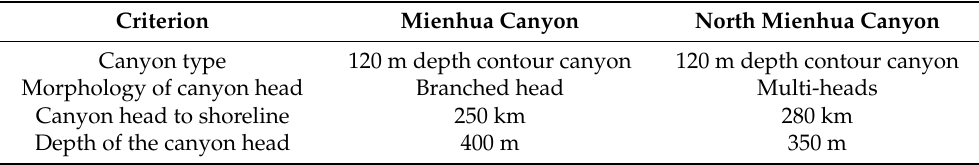
Figure 3. ( a ) River drainage and surrounding bathymetric contours of the NE Taiwan margin. Note the outline of the 120 m depth contour off the shore of NE Taiwan. ( b ) Shaded relief map of NE Taiwan. ( c ) Slope gradient map of NE Taiwan. Note that the shelves on the NE Taiwan margin are characterized by slope gradients of between 0 and 5 degrees. Mienhua and North Mienhua canyons, named for nearby islets, are confined to the slope areas. Huapinghsu Channel is aligned to the western branch of Mienhua Canyon [20]. HPC: Huapinghsu Channel; MHC: Mienhua Canyon; NMHC: North Mienhua Canyon. Table 3. Comparisons of submarine canyons along the NE Taiwan margin.